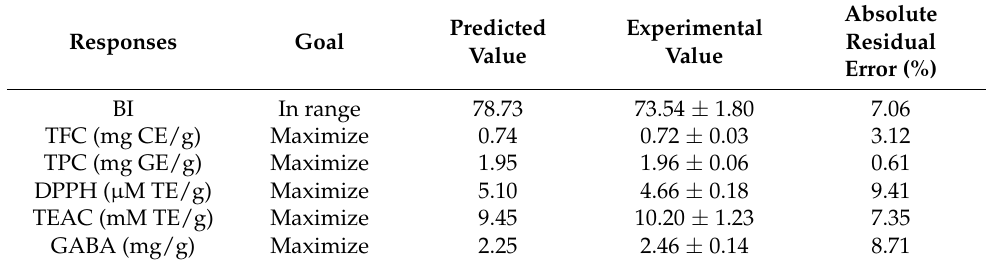
Table 5. Experimental runs with actual values of independent